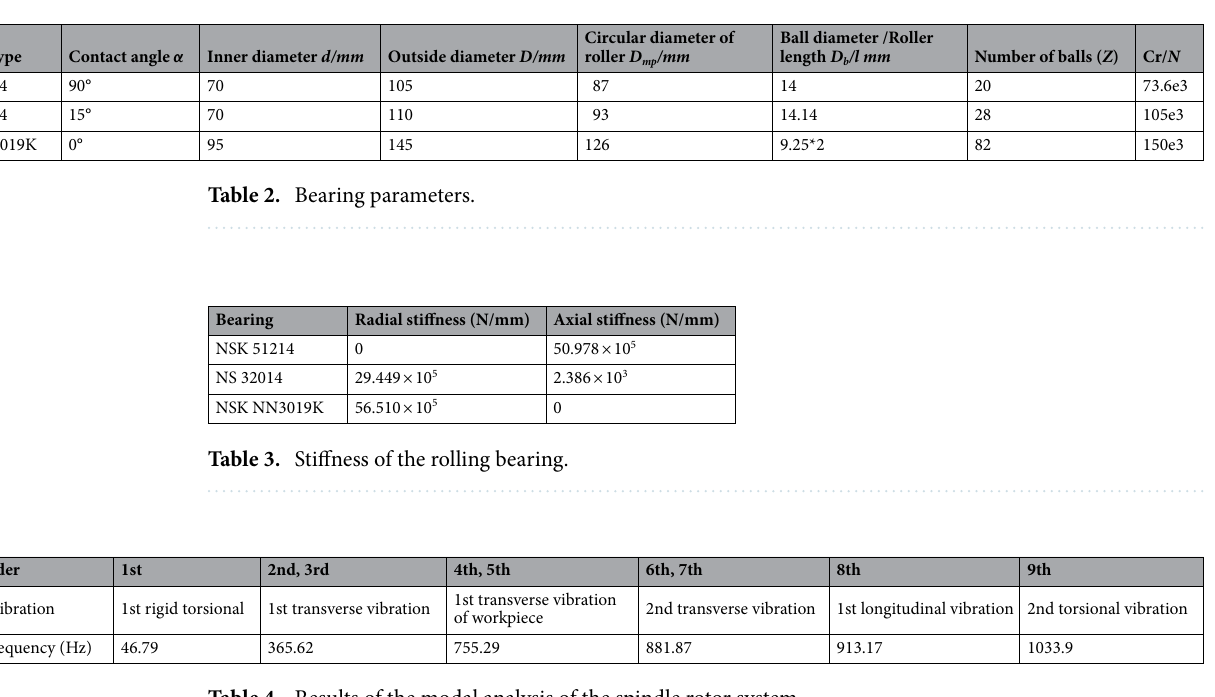
Table 4. Results of the modal analysis of the spindle rotor